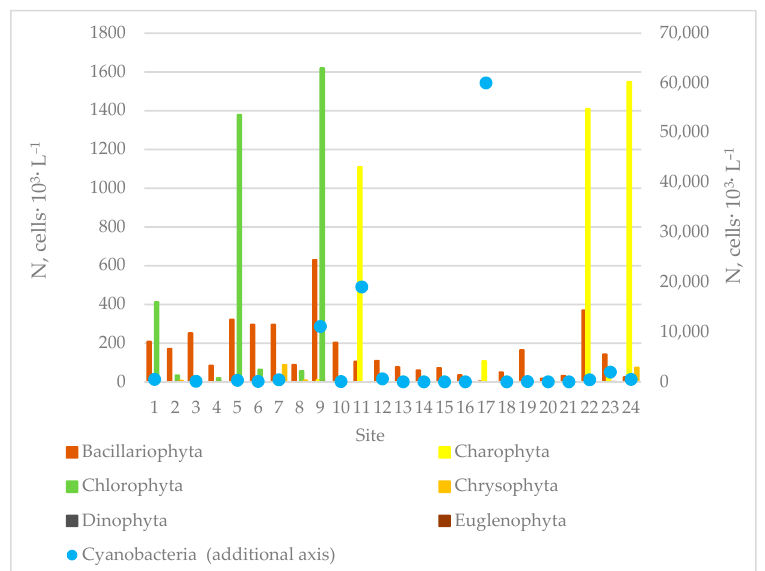
Figure 5. The abundance of the phytoplankton cells by divisions within the Ukrainian part of the Siversky Donets river basin. For a better visibility, an additional axis was added referring to Cyanobacteria.